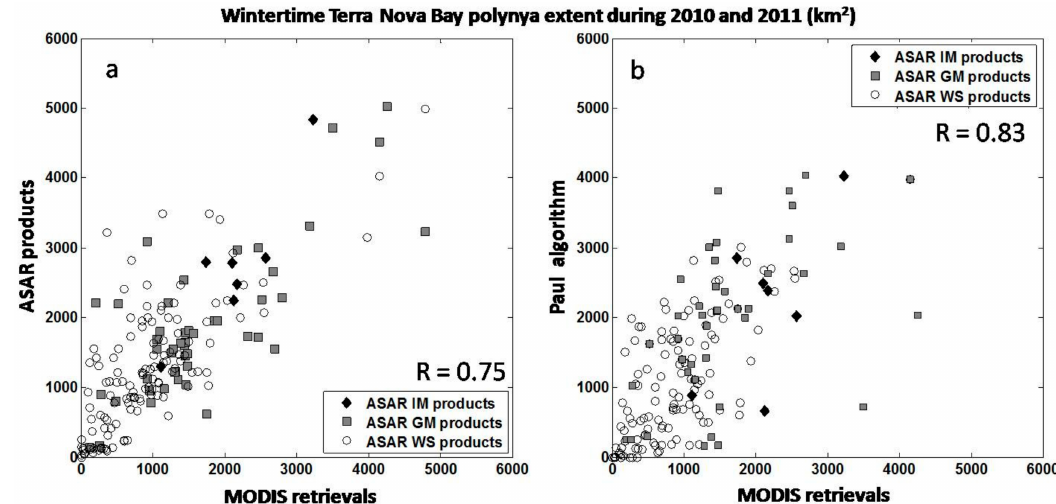
Figure 9. Scatter plots of Terra Nova Bay polynya extents retrieved through MODIS level 1b scenes during wintertime 2010 and 2011 and ( a ) ASAR ENVISAT co-located images; ( b ) polynya extents retrieved through POLA algorithm using MODIS products for the same day. White circles, grey squares and black diamonds identify WS, GM and IM ASAR products, respectively. Extents are in km 2 . R values represent the Pearson linear correlation